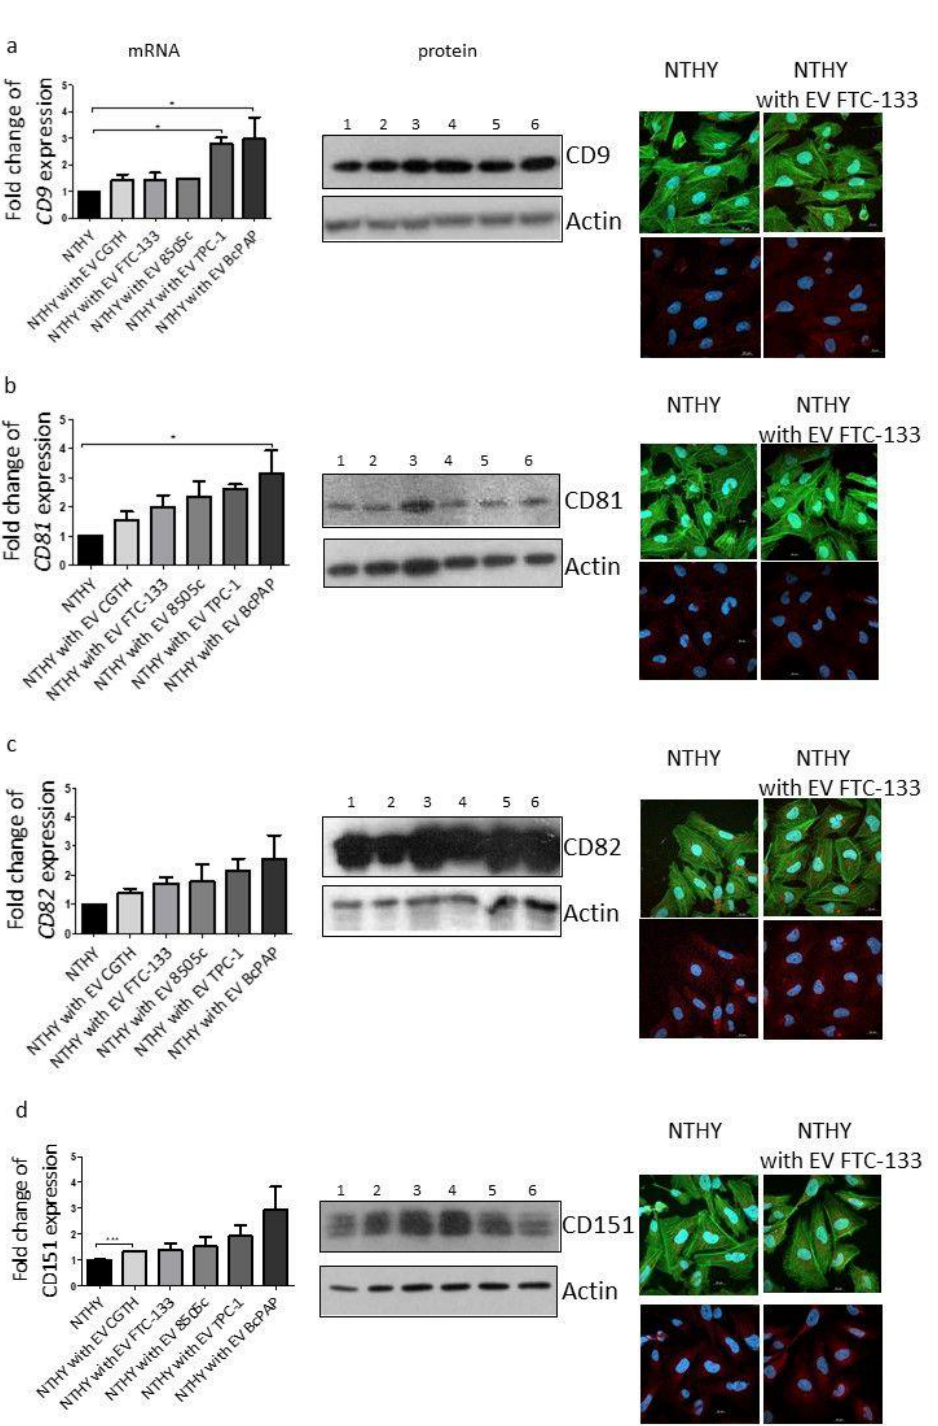
Figure 5. The effect of EVs derived from thyroid cancer cells on the expression of tetraspanins in NTHY cells. The expression of tetraspanins is shown in separate panels: CD9 ( a ); CD81 ( b ); CD82 ( c ); and CD151 ( d ). Each panel shows: the level of gene expression (qRT-PCR) (the graphs placed on the left side of the figure); the level of protein expression (WB) (the images placed in the middle); the representative images of ICC/IF analysis (the microscopic photographs shown on the right side of the figure). Line 1: NTHY alone; 2: CGTH; 3: FTC-133; 4: 8505c; 5: TPC-1, 6: BcPAP. Data are shown as means with standard deviation ( ± SEM). *: p < 0.05, ***: p <